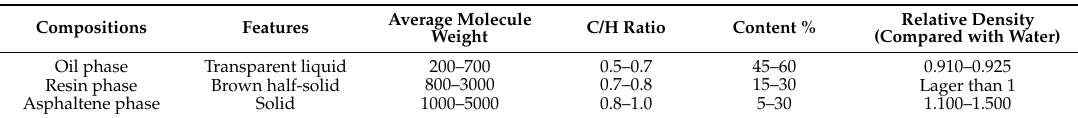
Table 1. Summary on bitumen